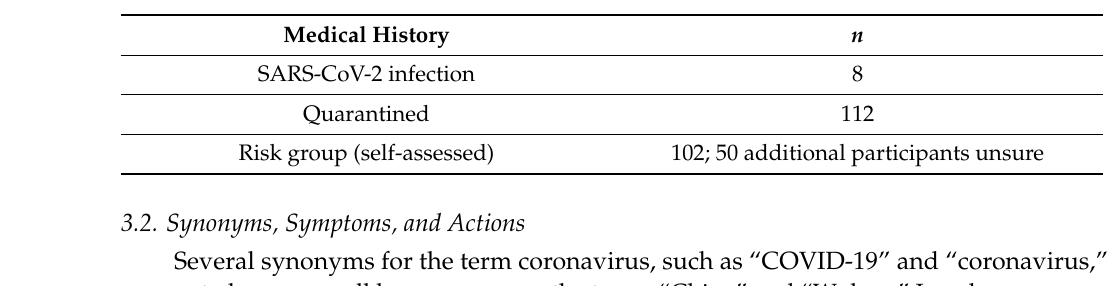
Table 2. COVID-19-related medical history (N = 863 after excluding ineligible participants).